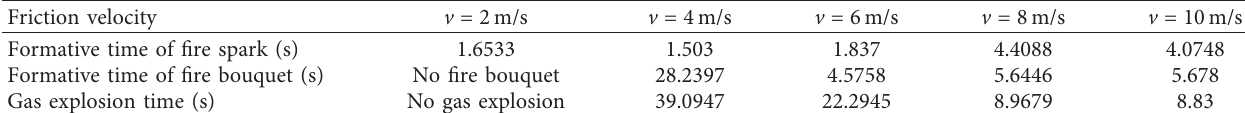
Figure 7: Typical experimental results of different friction velocities. (a) v � 2m/s. (b) v � 4m/s. (c) v � 6m/s. (d) v � 8m/s. (e) v � 10m/s. Table 1: Time of occurrence of point sparks at different friction velocities and time of gas